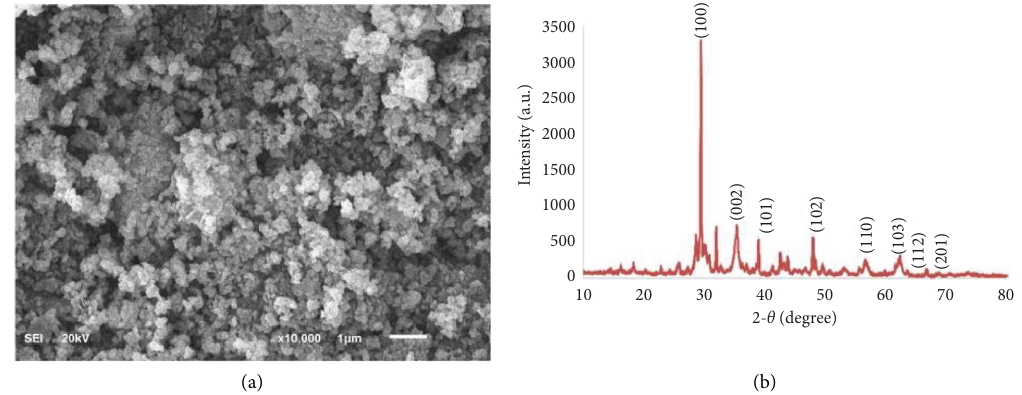
Figure 1: Confrmation for the presence of ZnO NPs in ZnO NPs-modifed cathodes using (a) SEM analysis and (b) XRD analysis.